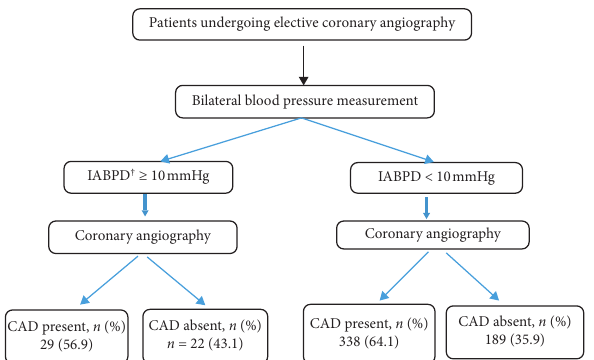
Figure 1: Study flowchart. Note: † interarm systolic blood pressure